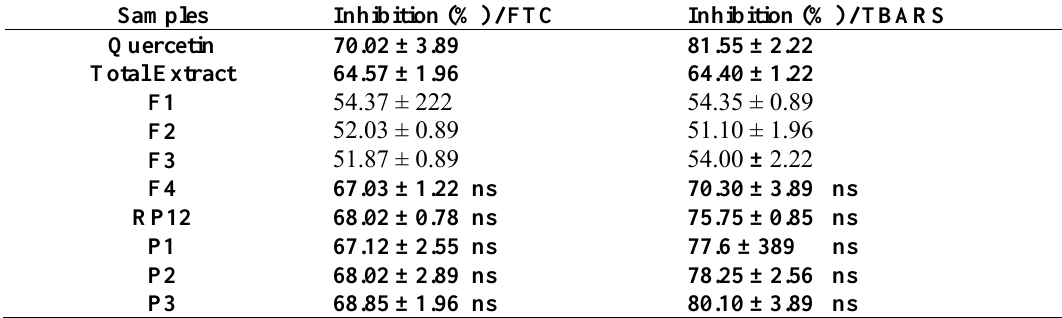
Table 5. Lipidic peroxidation with FTC and